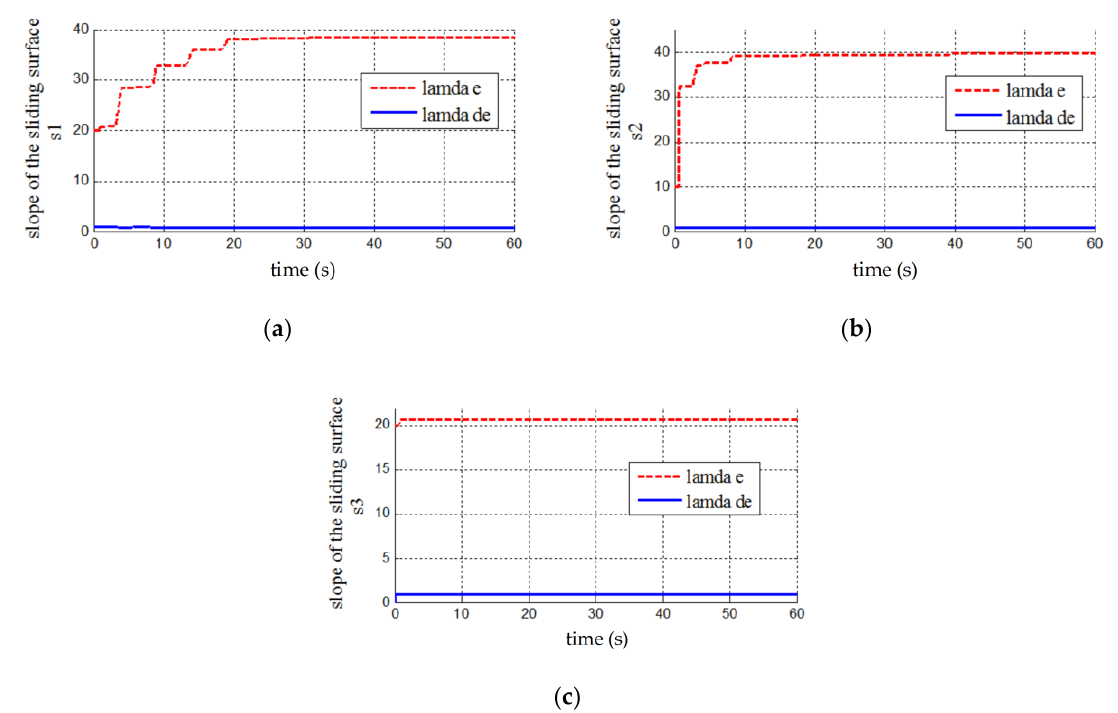
Figure 15. The slope adjusted for the sliding surface of the ( a ) first joint, ( b ) second joint, ( c ) third joint.